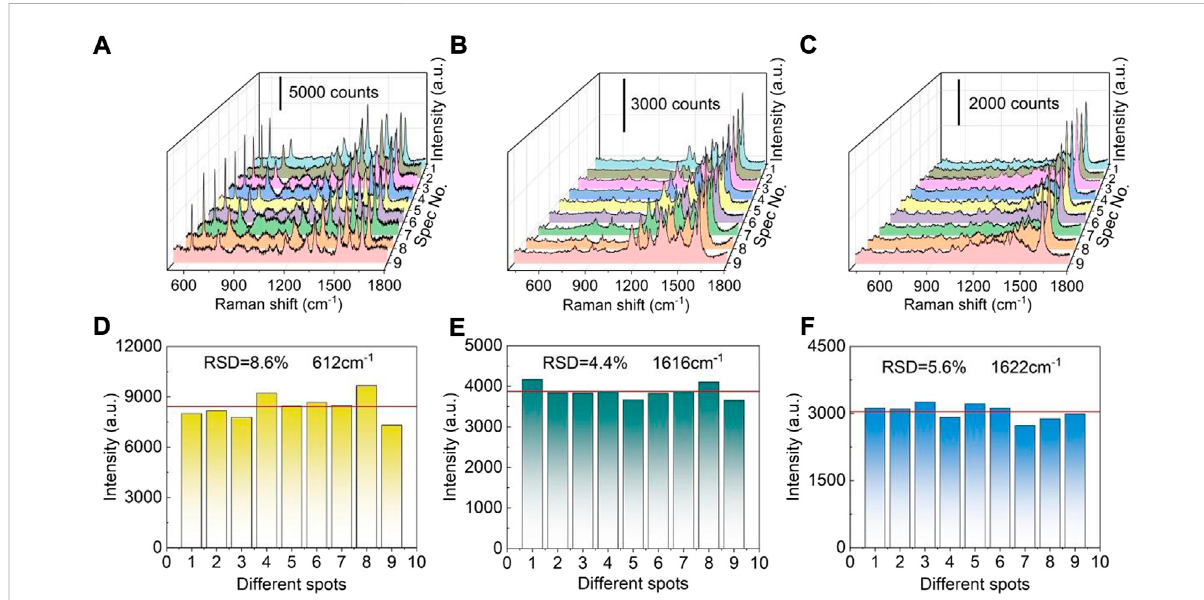
FIGURE 3 SERS signal uniformity of the Ag nanoparticles modi fi ed TiO 2 nanotube arrays. (A) SERS spectra of R6G (10 − 7 M) at different positions. (B) SERS spectra of MG (10 − 5 M) at different positions. (C) SERS spectra of MB (10 − 5 M) at different positions. (D) The 612 cm − 1 band intensities of R6G (10 − 7 M) recorded from different locations. (E) The 1,616 cm − 1 band intensities of MG (10 − 5 M) recorded from different locations. (F) The 1,622 cm − 1 band intensities of MB (10 − 5 M) recorded from different